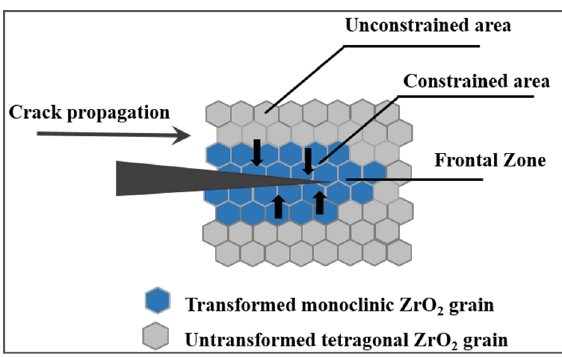
Figure 11. Schematic illustration of stress-induced phase transformation